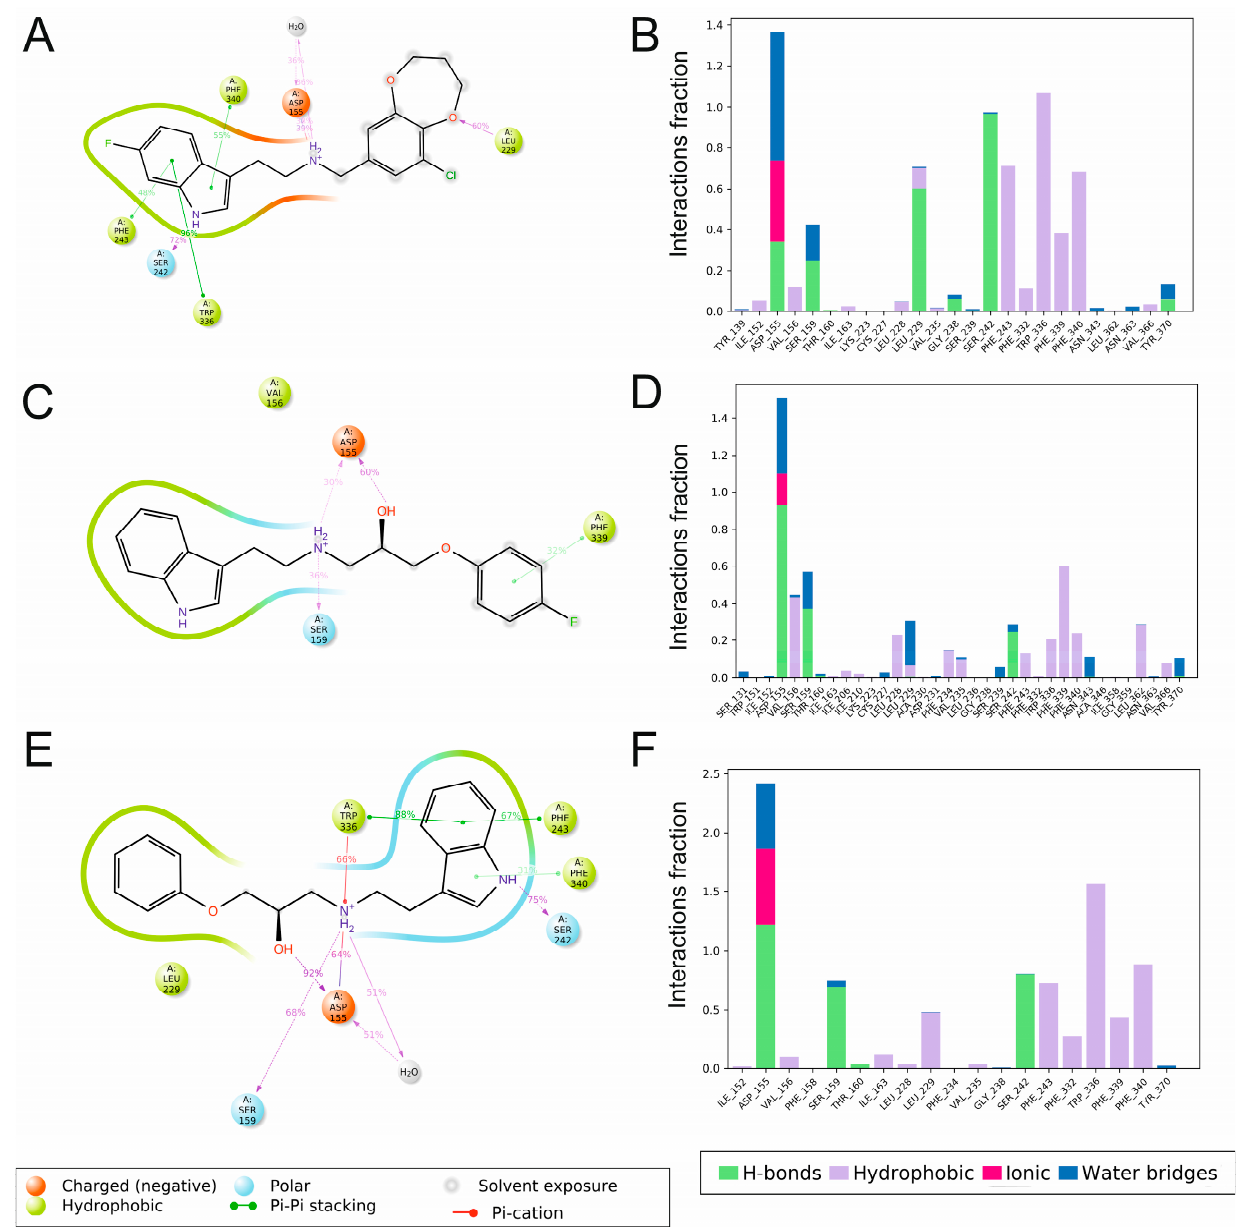
Figure 7. Ligand–receptor contacts ( A , C , E ) and histograms of ligand–receptor interactions ( B , D , F ) for serotonin 5-HT 2A receptor in complex with D2AAK5 ( A , B ), D2AAK6 ( C , D ), and D2AAK7 ( E , F ) during 1 μ s molecular dynamics simulations. The stacked bar charts are normalized over the course of the trajectory: for example, a value of 0.7 suggests that 70% of the simulation time the specific interaction is maintained. Values over 1.0 are possible as some protein residue may make multiple contacts of same subtype with the ligand.